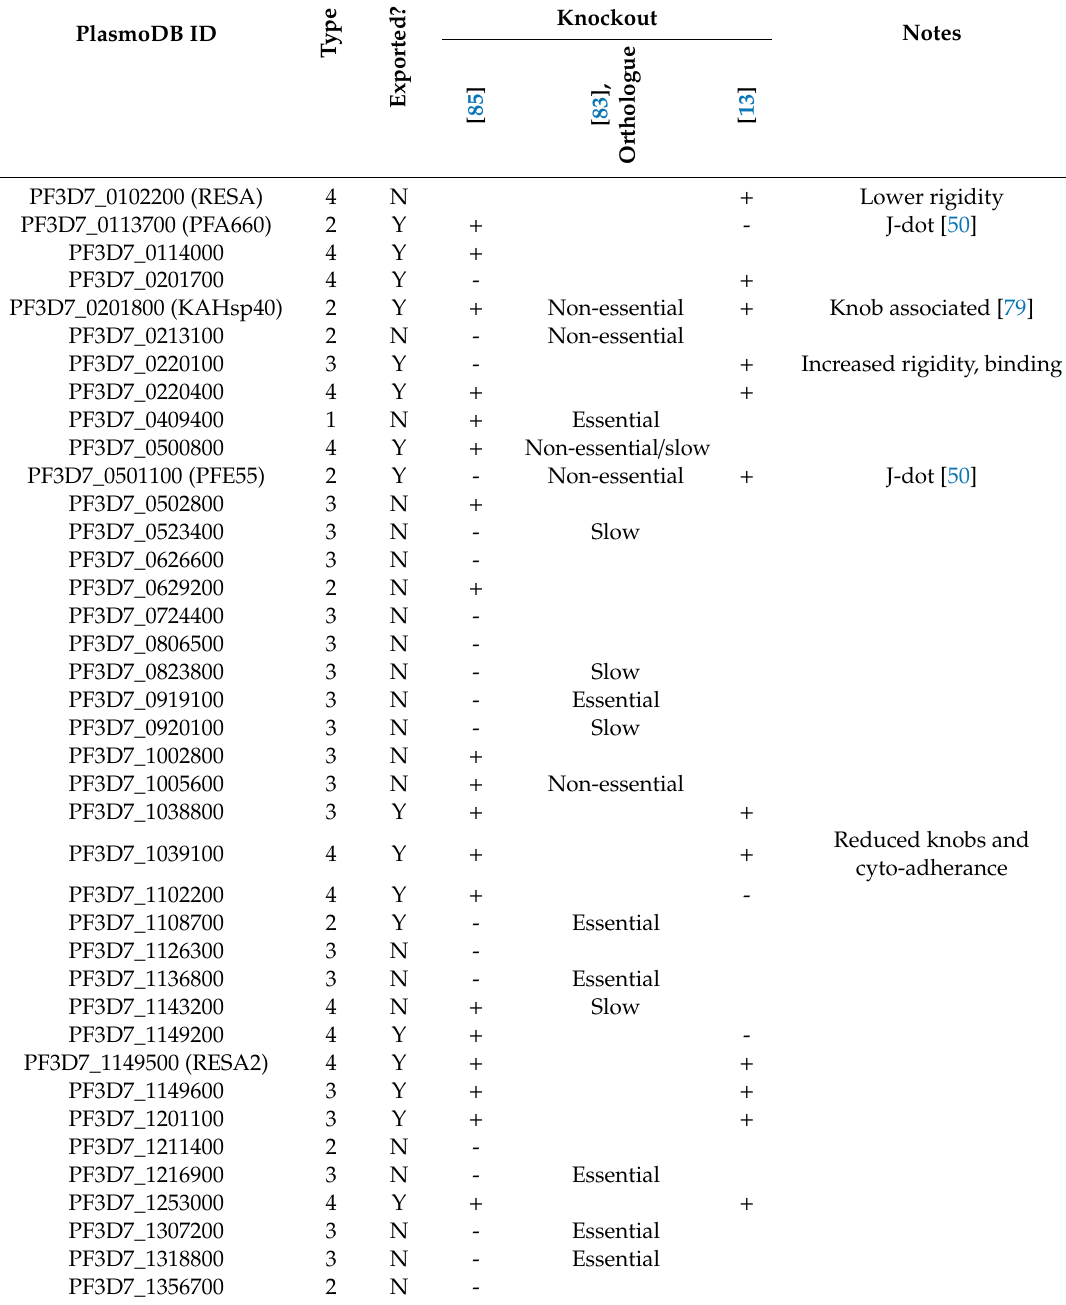
Table 1. Characteristics of Hsp40